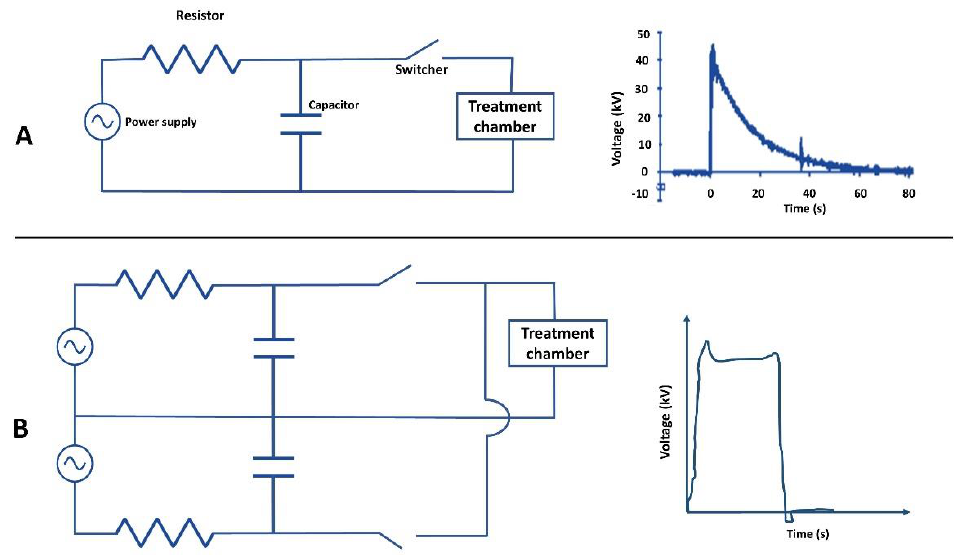
Figure 3. The two main types of electrical circuits and their possible pulses shapes: ( A ) simple resistance–capacitance ( RC ) circuit and its exponentially decaying pulse shape; ( B ) complex electric circuit and its square pulse shape.